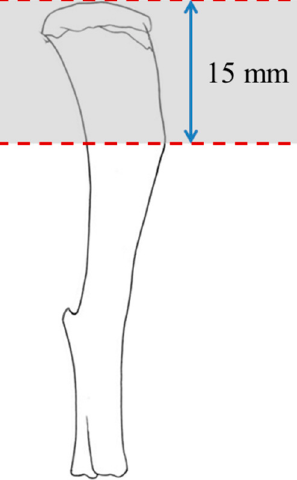
Figure 1. The metaphyseal region of tibia chosen for analysis.